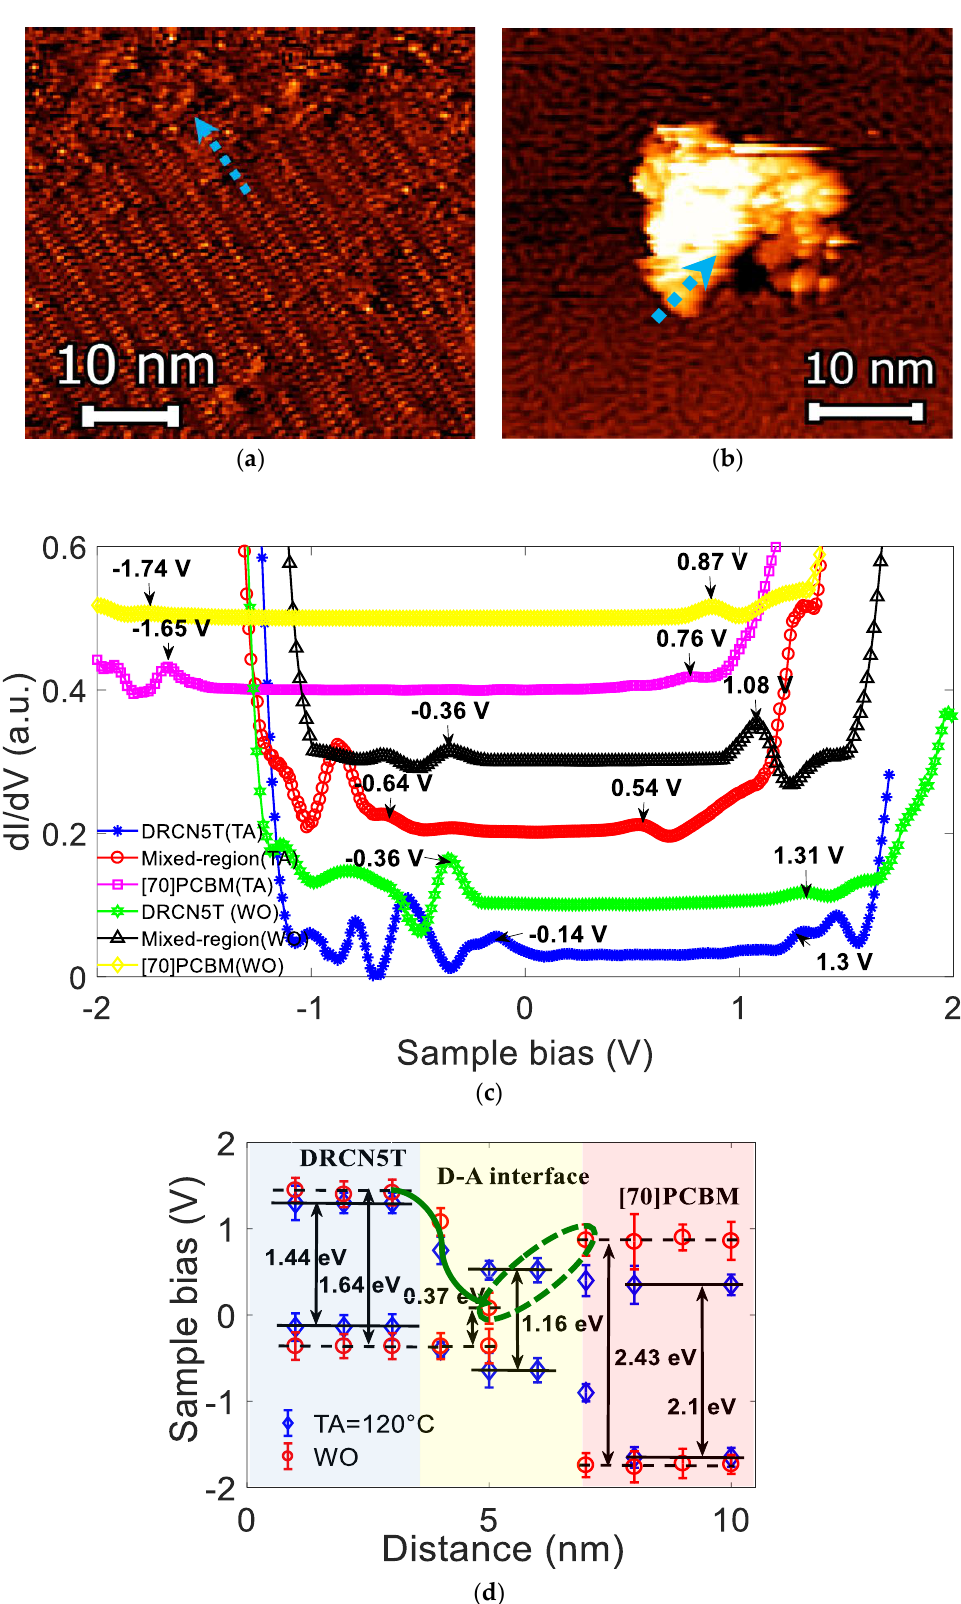
Figure 4. STM and STS of DRCN5T:[70]PCBM blend films, ( a ) Without thermal annealing (WO); tunneling conditions: It = 200 pA, U = 950 mV, ( b ) TA@120 ◦ C; tunneling conditions: It = 200 pA, U = 950 mV, ( c ) Average LDOS measurements across the DRCN5T:[70]PCBM film domains, ( d ) Energetic band alignment across the DRCN5T:[70]PCBM